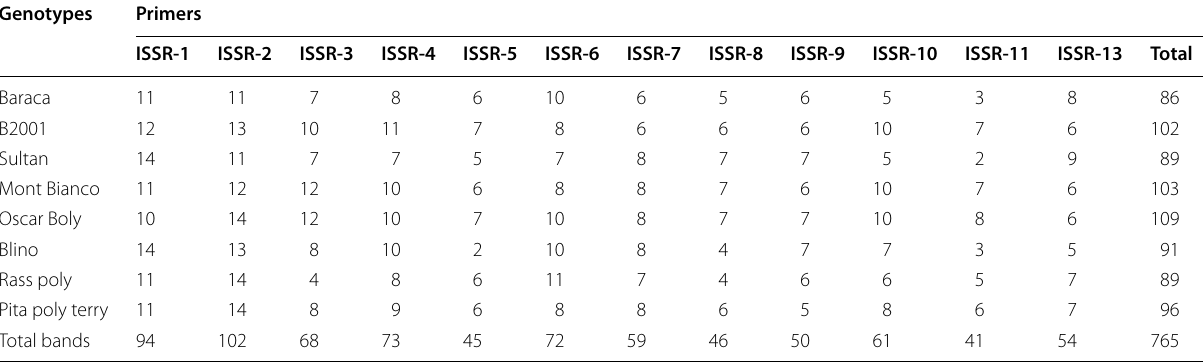
Table 7 Total bands obtained from the twelve ISSR primers of the eight sugar beet accessions and all amplified fragments for each genotype Genotypes